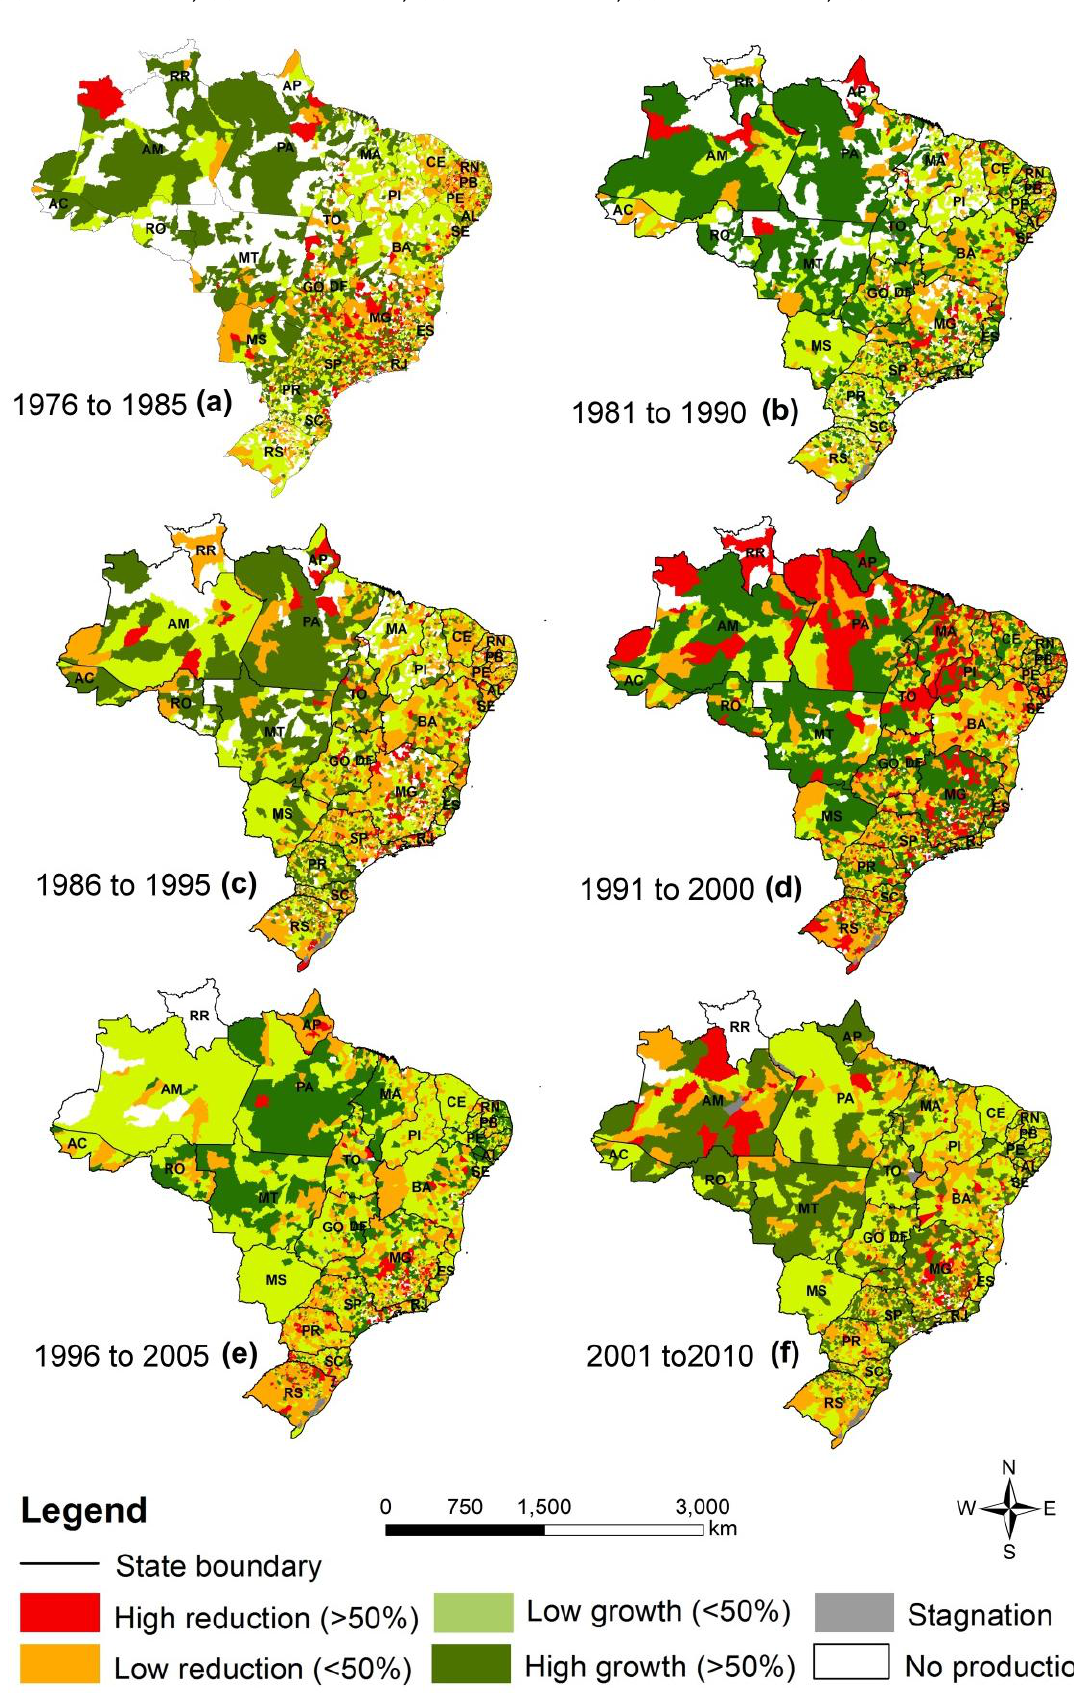
Figure 1. Brazilian sheep production growth rates from 1976 to 2010. ( a ) 1976 to 1985; ( b ) 1981 to 1990; ( c ) 1986 to 1995; ( d ) 1991 to 2000; ( e ) 1996 to 2005; ( f ) 2001 to